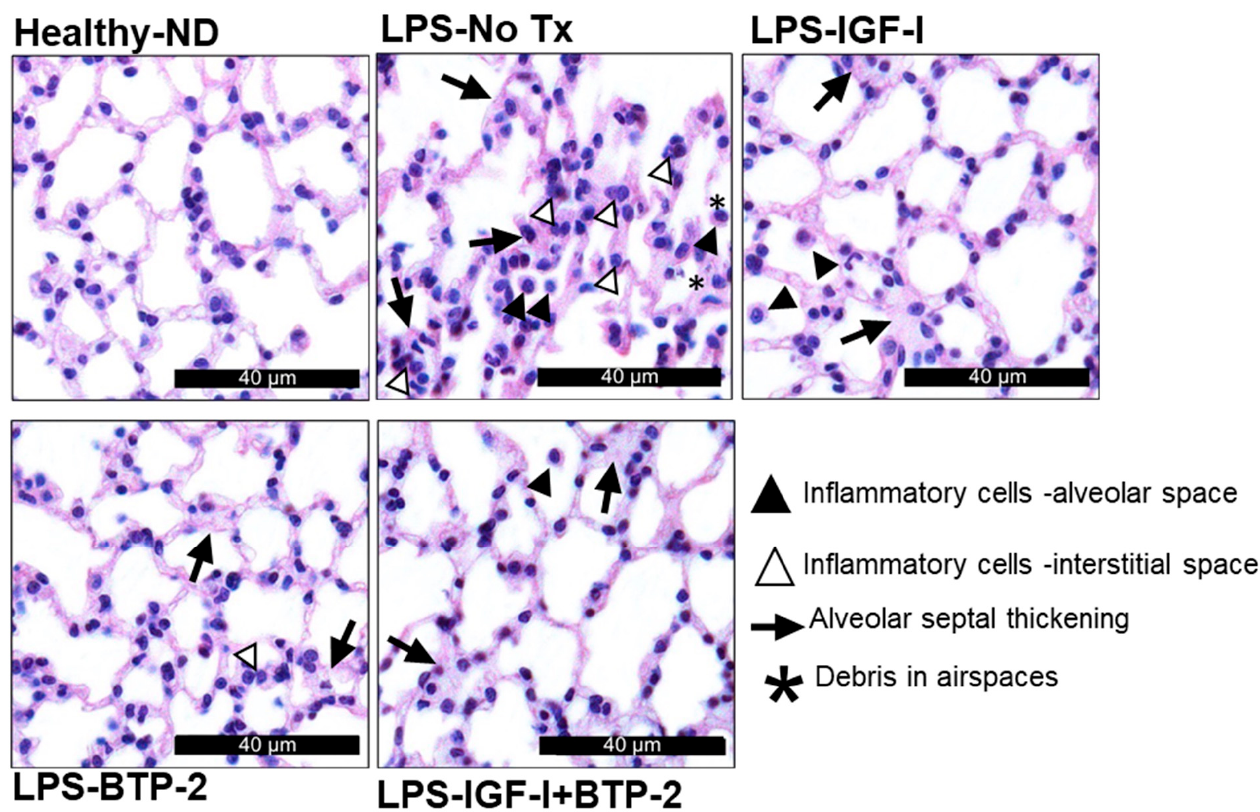
Figure 6. Effects of the IGF—I and BTP—2 monotherapies and the IGF—I + BTP—2 combination therapy on the tissue structures in the lungs. H&E staining of the lung section on Day 7. Scale: 40 µM.